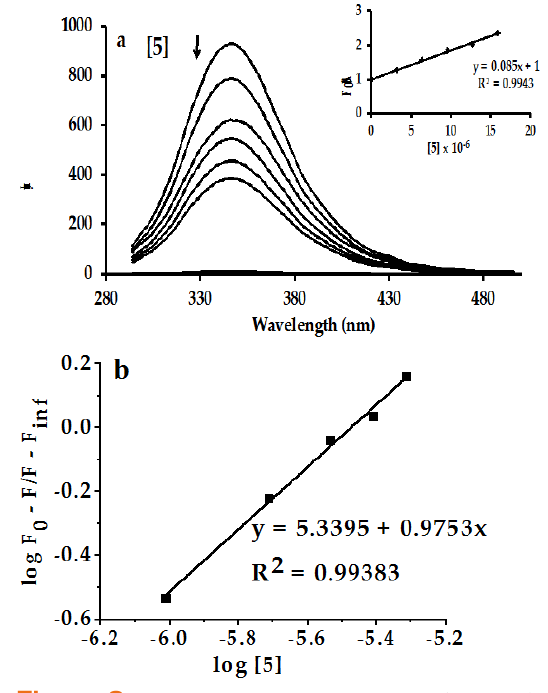
Figure 8. (a) Spectral changes of BSA (3×10 -6 mol dm -3 ) on addition of 5 (0 to 4.86×10 -6 mol dm -3 ) in aqueous medium. Inset is the Stern Volmer’s plot and (b) Binding plot of BSA to 7